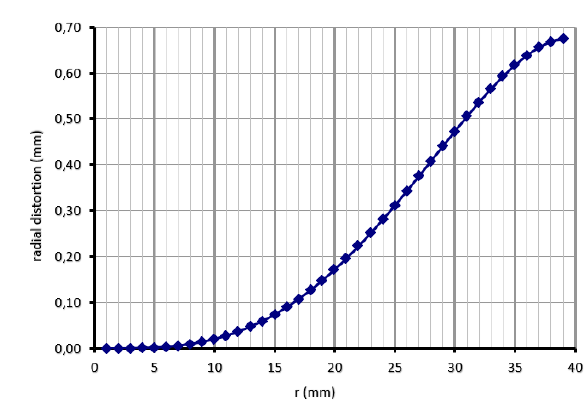
Figure 9. Radial distortion for 40 mm lens.